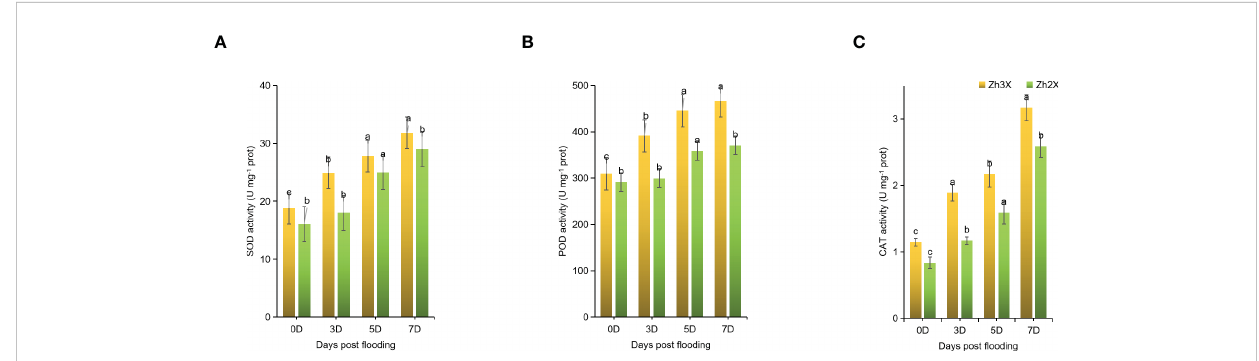
FIGURE 3 Fluctuation in the activities of SOD, POD, and CAT. (A) SOD, (B) POD), and (C) CAT. Perpendicular bars display averages ± SD (n = 6). Lower case letters above each bar present signi fi cant changes at p < 0.05 (Duncan ’ s multiple range